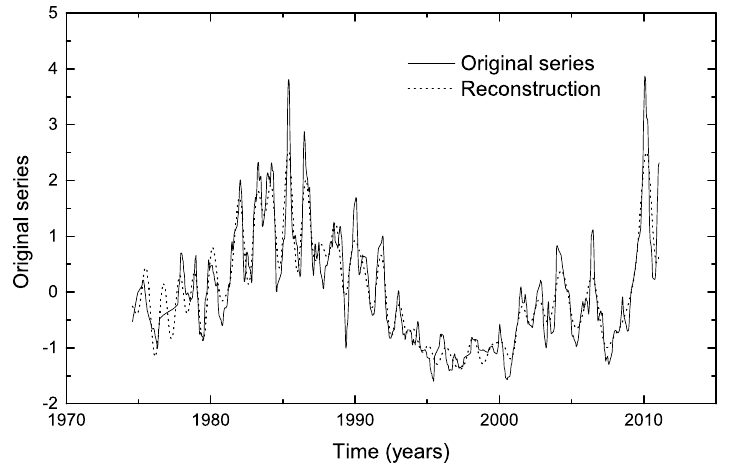
Fig. 7. Reconstruction of the original series at 14.5